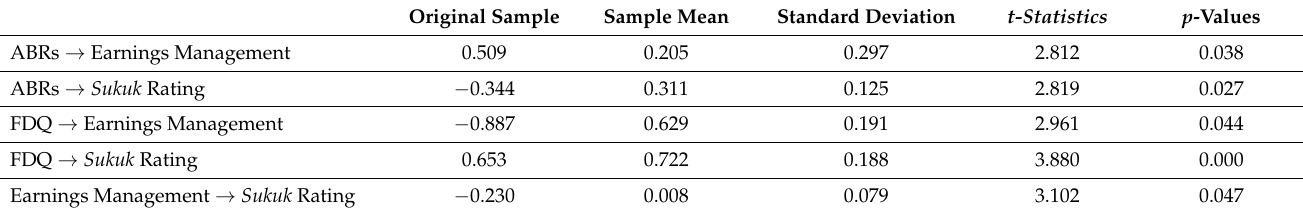
Table 6. Path Coefficients.